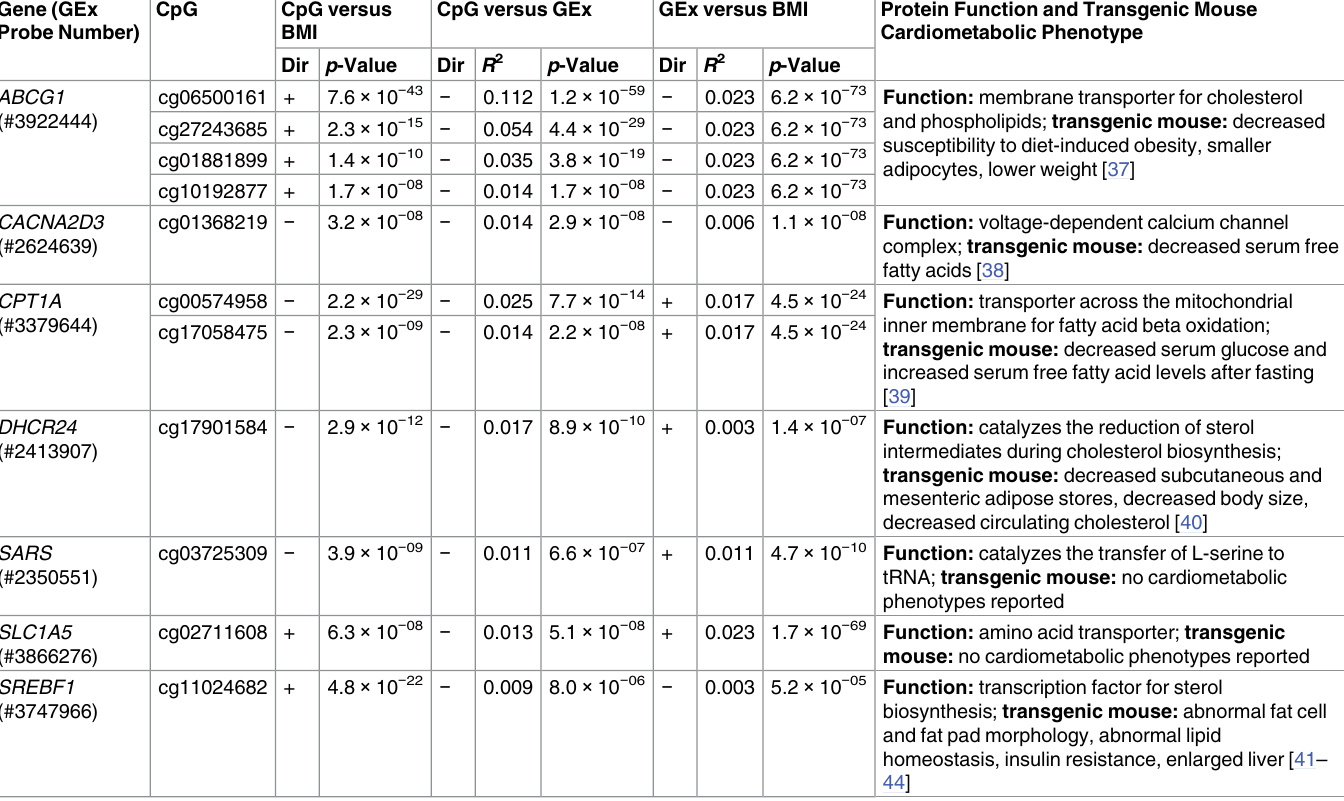
Table 4. Association results from 11 replicated CpGs with significant three-way associations in whole blood between CpG methylation and BMI, CpG methylation and gene expression, and gene expression and BMI. Gene (GEx CpG Probe Number)